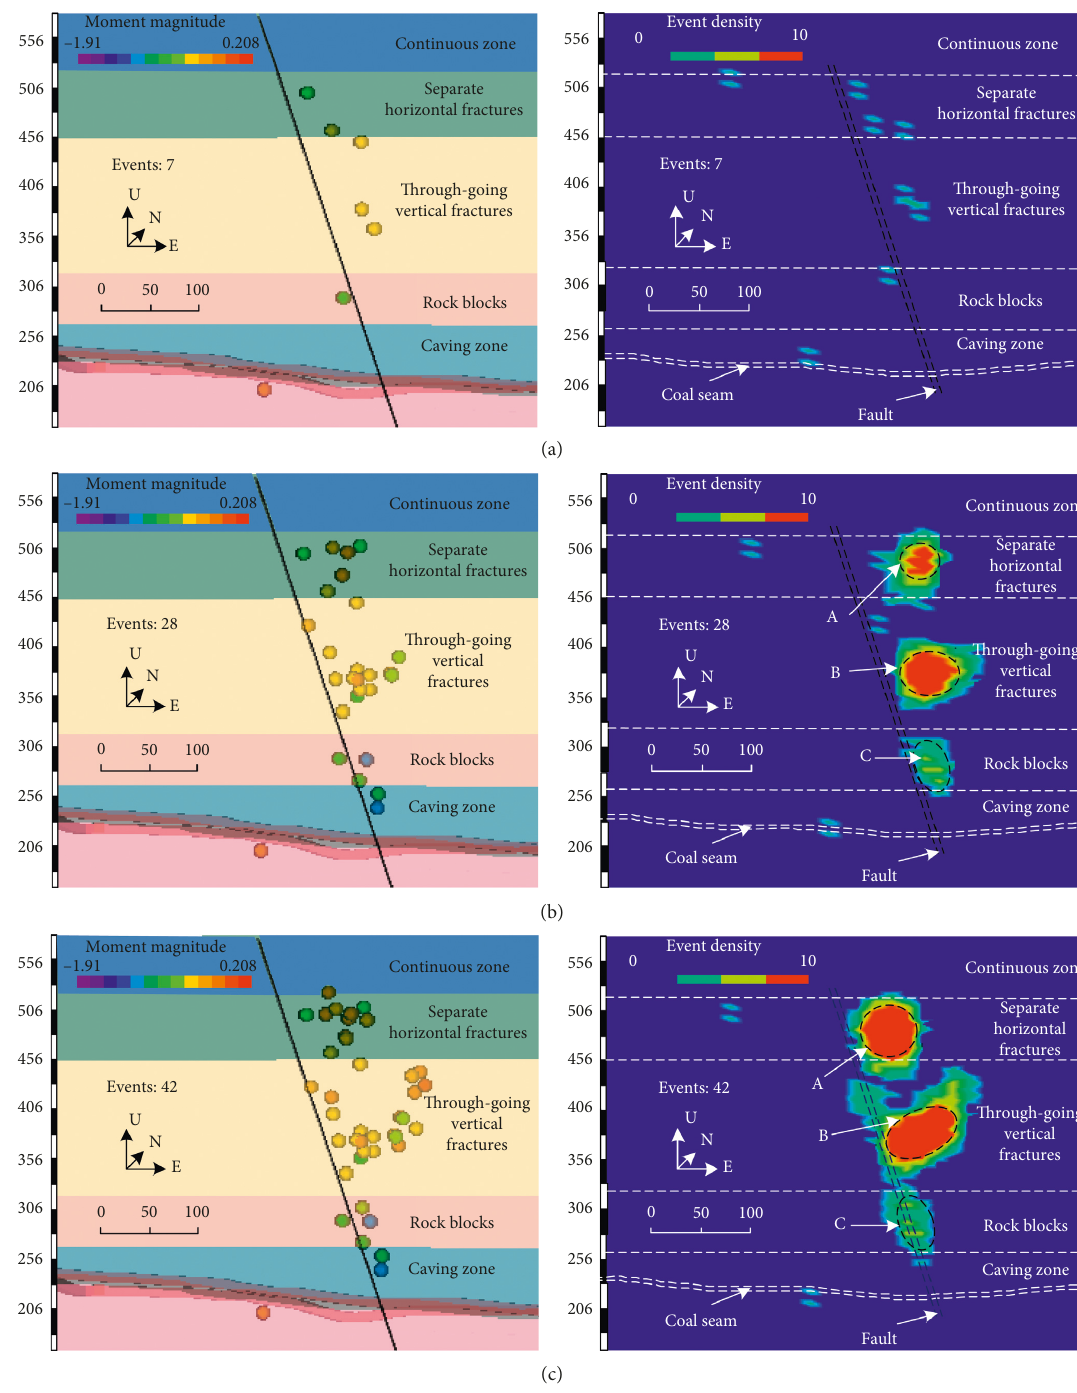
Figure 3: Vertical section projection of the microseismic events around fault area between Nov 12, 2015, and Dec 15, 2015,